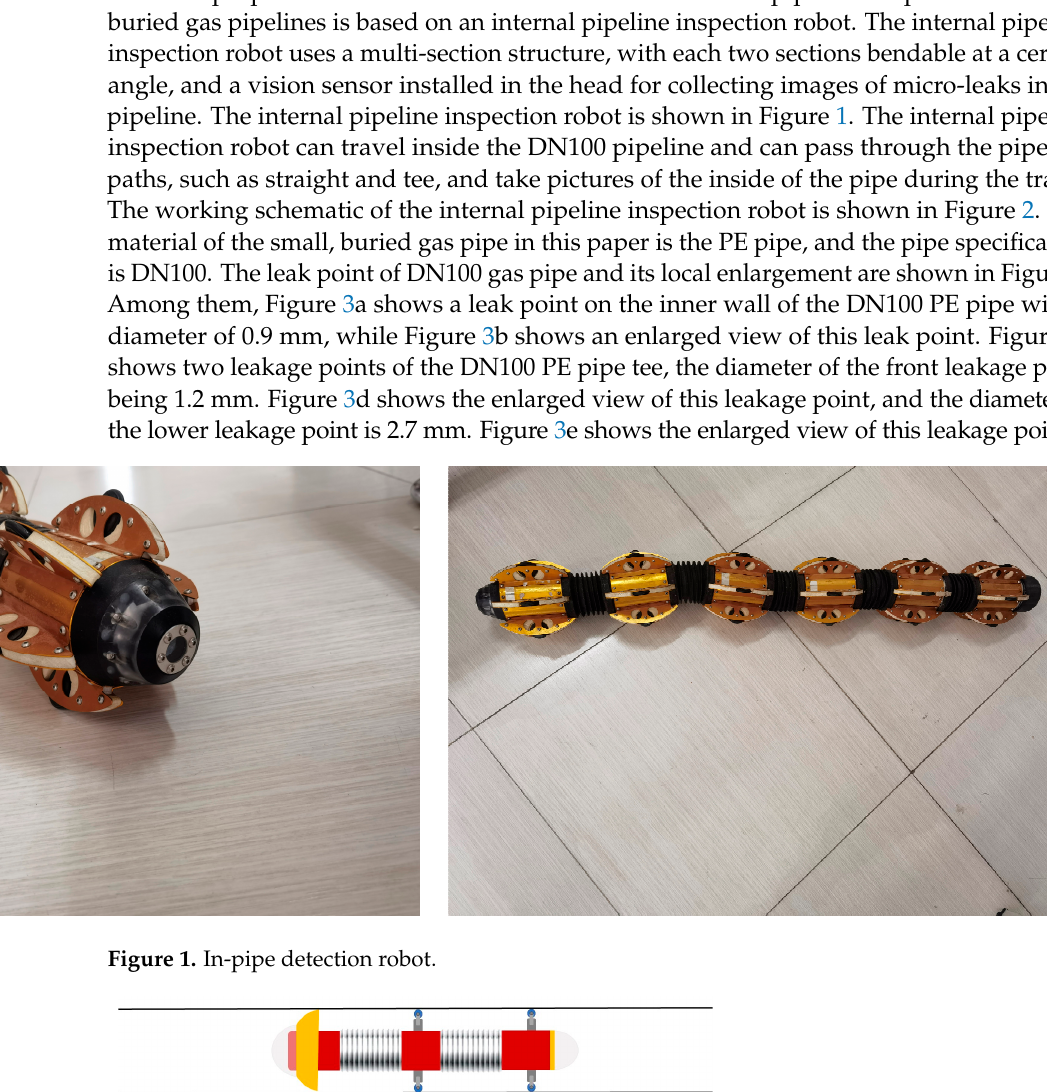
Figure 2. Working diagram of the internal pipeline inspection